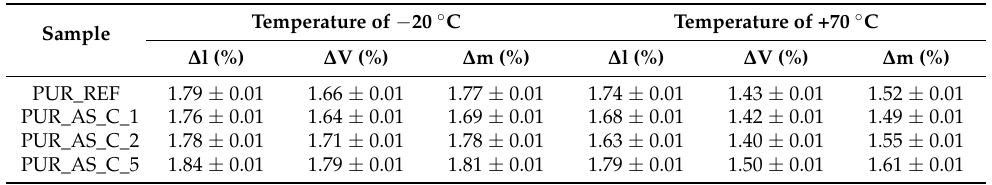
Table 6. Changes in linear dimensions ( ∆ l), volume ( ∆ V), and mass ( ∆ m) after conditioning at –20 and +70 ◦ C, of PUR